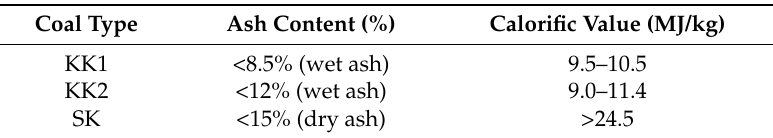
Figure 7. Historical data of ash content of delivered trains to the power plants (provided by Mitteldeutsche Braunkohlengesellschaft mbH ( MIBRAG).